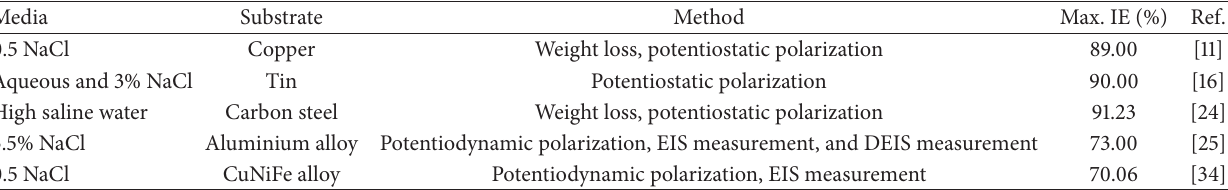
Table 6: Properties of honey derivatives as corrosion